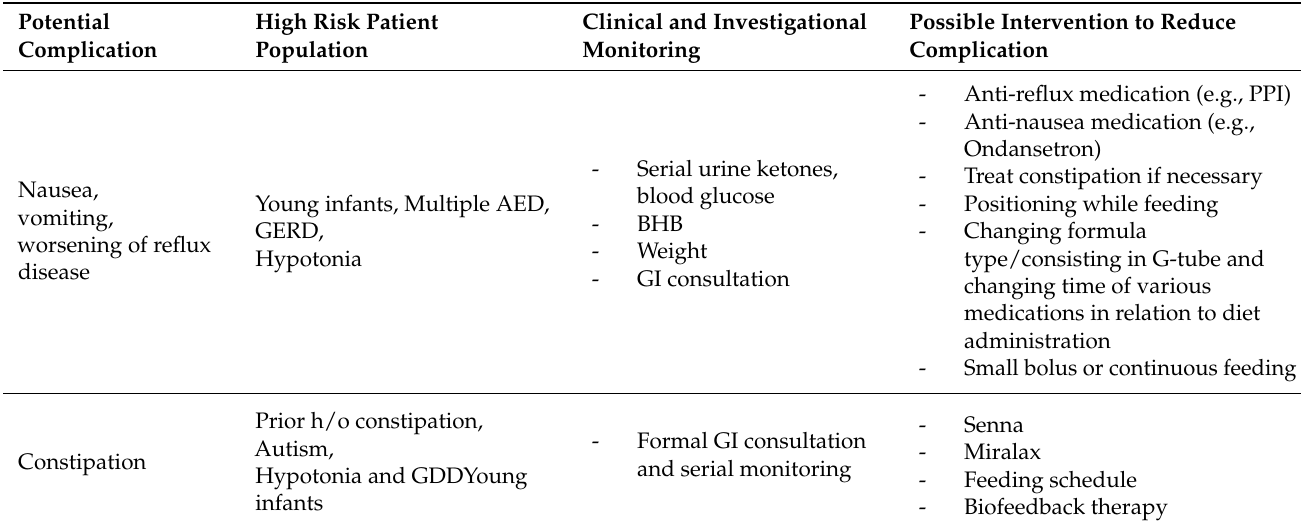
Table 2. Potential complications according to high-risk patient populations, with the corresponding appropriate clinical monitoring and